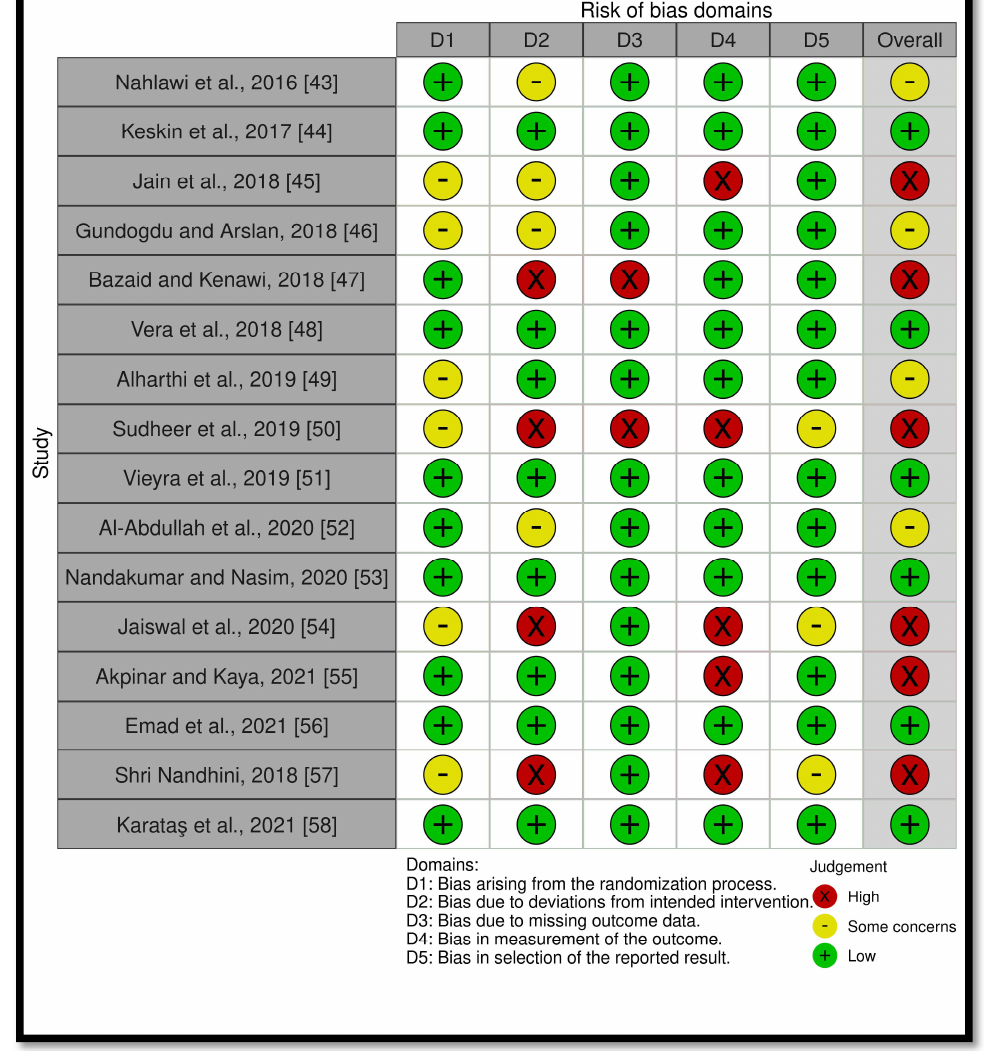
Figure 2. Summary of the risk assessment bias (RoB 2) of the included randomized controlled trials.